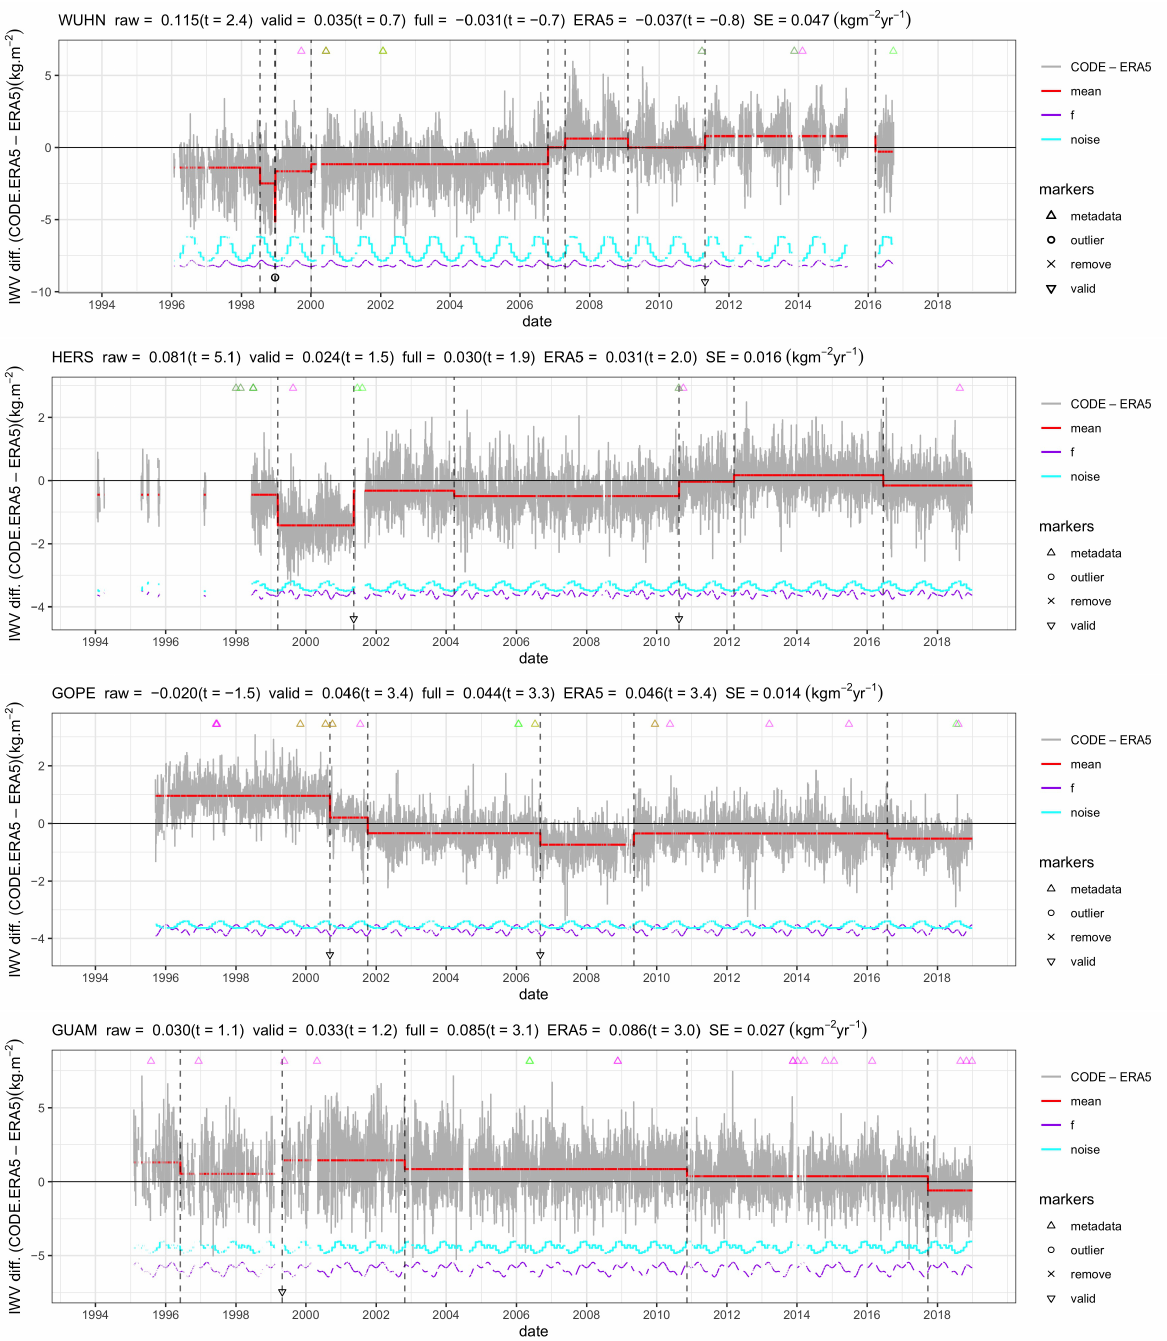
Figure 14. Similar to the upper plot in Figure 4, but for different stations: HERS (Hailsham, United Kingdom), GOPE (Ondrejov, Czech Republic), KOKB (Waimea, United States), and GUAM (Dededo, Guam). The IWV differences are computed as GNSS - ERA5, where GNSS is converted using auxiliary data from ERA5, and the segmentation is run with ERA5 as a